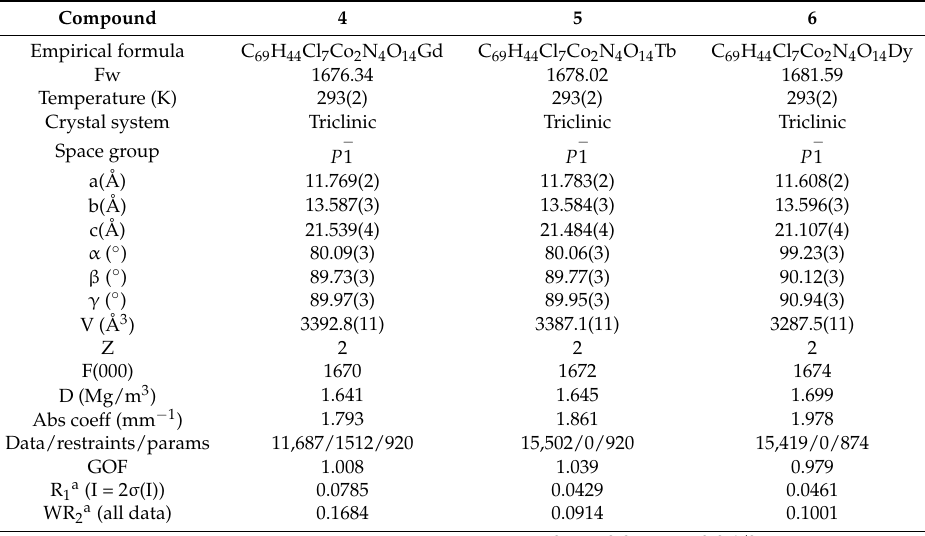
Table 2. Crystal data and structure refinement information for 4 – 6.